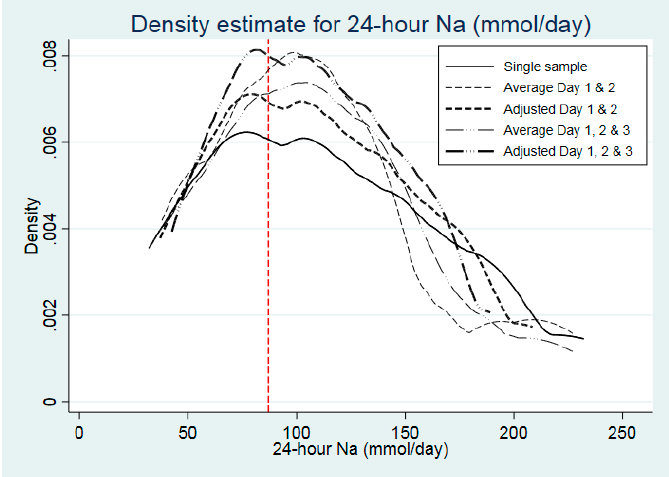
Figure 2. Population distribution of 24 h urinary Na (mmoL/day), according to number of days of urine collection ( n = 23). Density refers to proportion of persons, e.g. 0.002 = 0.2%). Solid line: raw data from day1 only; thin dashed line: after correction for average of day1 and day2; thick dashed line after correction for intra-individual variation of day1 and day2; thin long dashed & dotted line: after correction for average of all three days; thick long dashed & dotted line after correction for intra-individual variation of all three days. Vertical dashed lines correspond to 5 g salt/day (equivalent to 87 mmoL/day).